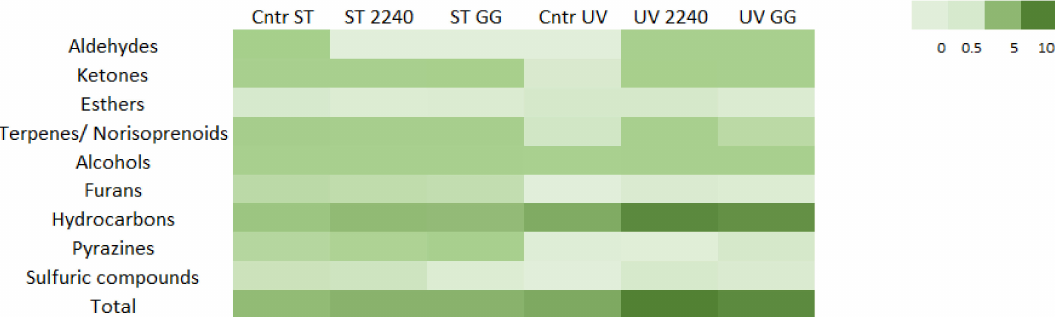
Figure 3. Heat map performed on volatile chemical classes’ concentrations detected in sterilized (ST) or UV-treated (UV) A. platensis biomasses fermented with L. casei 2240 (2240) and L. rhamnosus GG (GG) as well as treated but unfermented biomasses (Cntr). A scale ranging from a maximum of 10 µ g/g (dark green) to a minimum of 0 µ g/g (light green) was